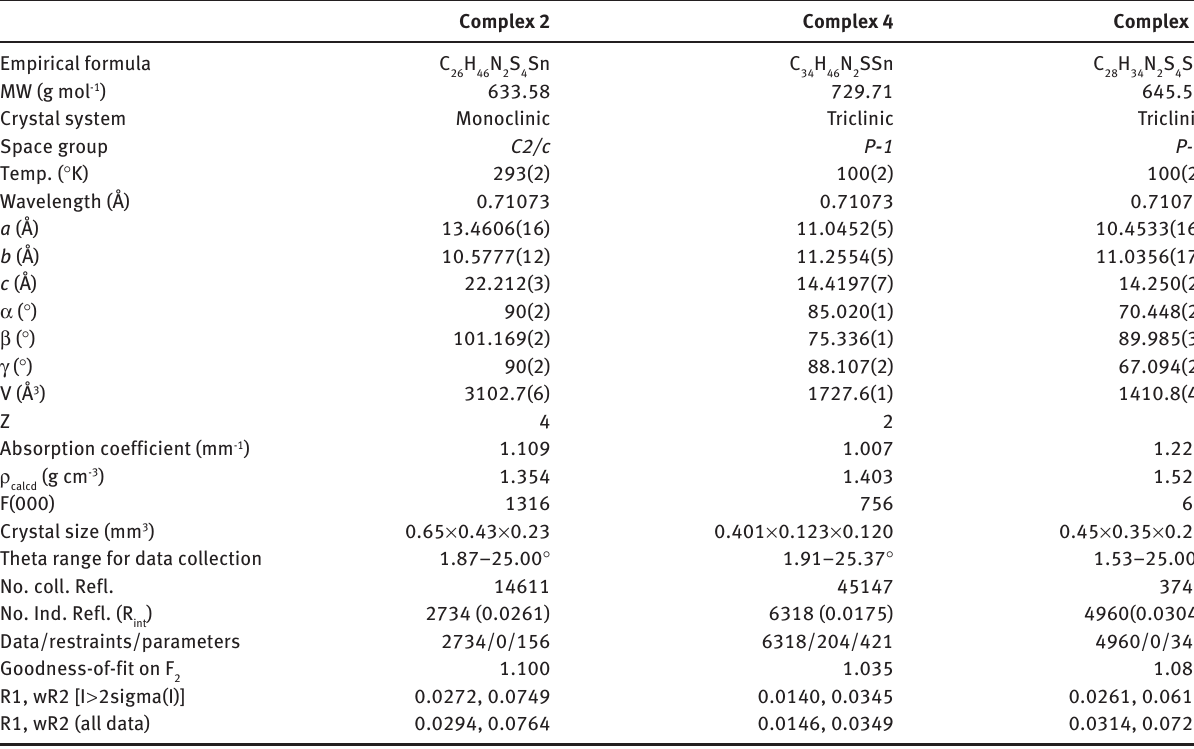
Table 1 Crystal data and structure refinement for complexes 2 , 4 , and 5 .